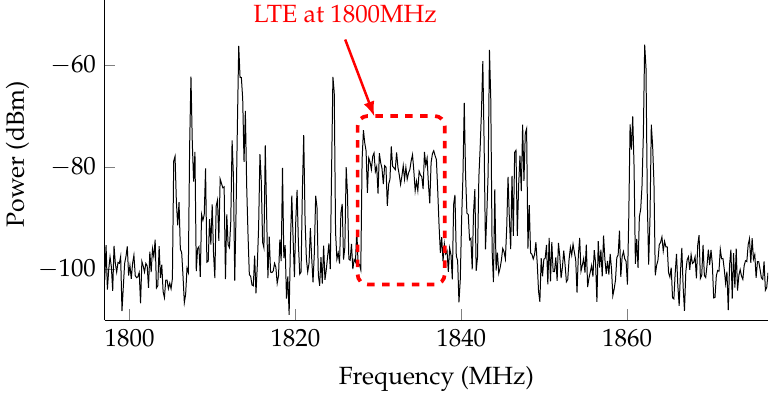
Figure 5. Operator refarming at 1800 MHz. Figure 4b from